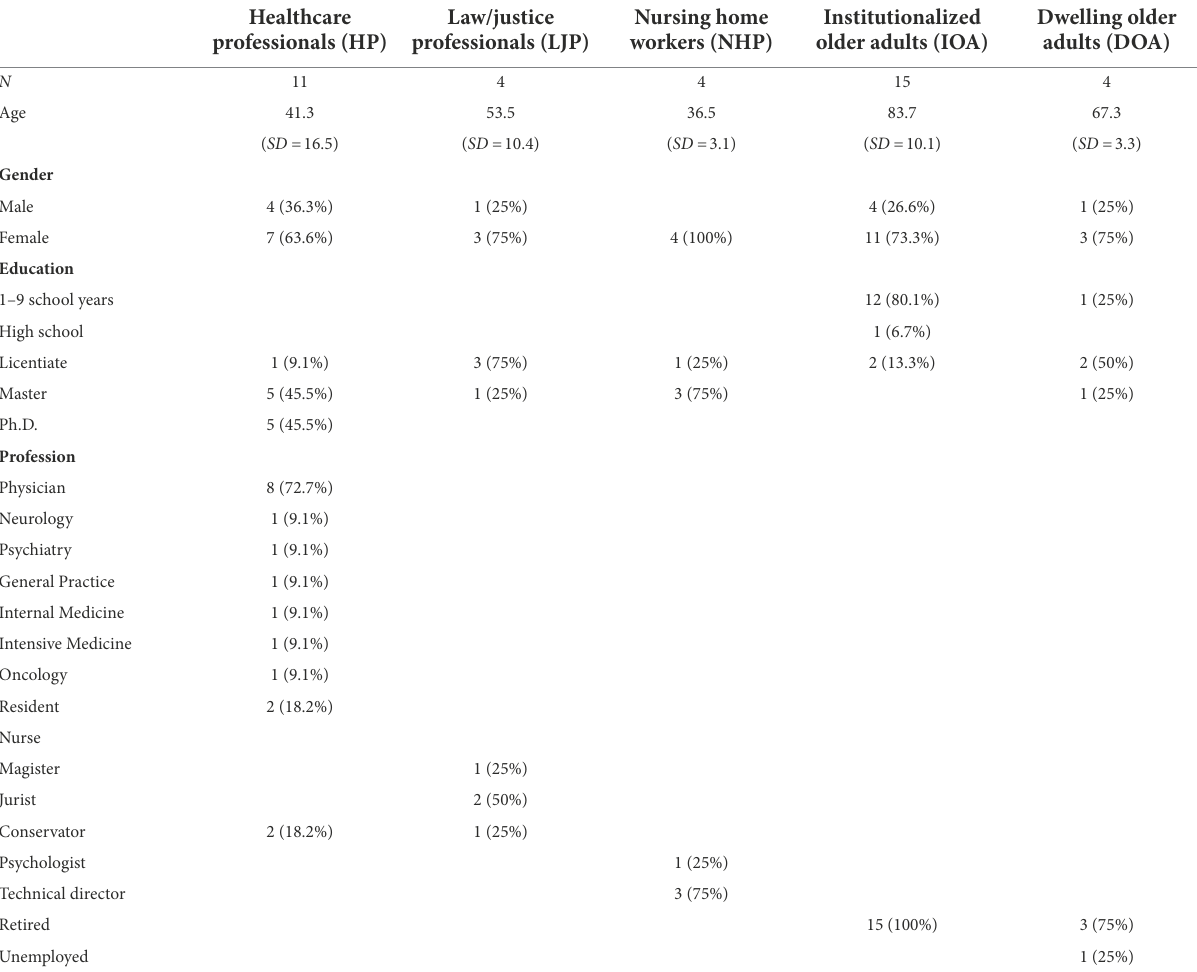
TABLE 1 Participants’ sociodemographic